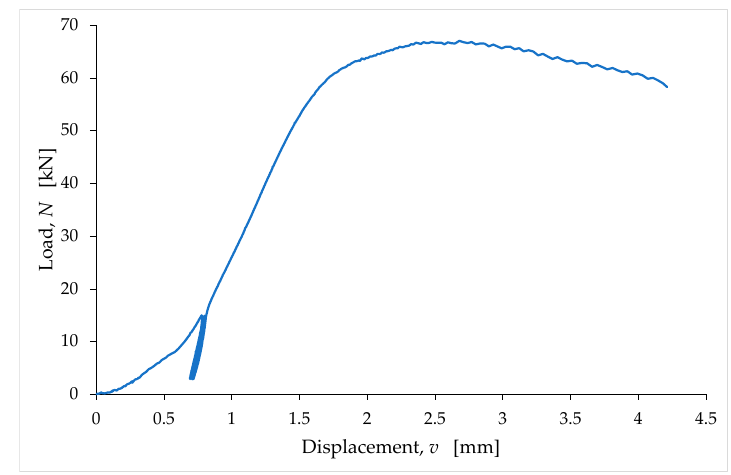
Figure 6. Acquired 𝑁 𝑣 ⁄ curve for the LT6 specimen (180 curing days). Figure 6. Acquired N / v curve for the LT6 specimen (180 curing